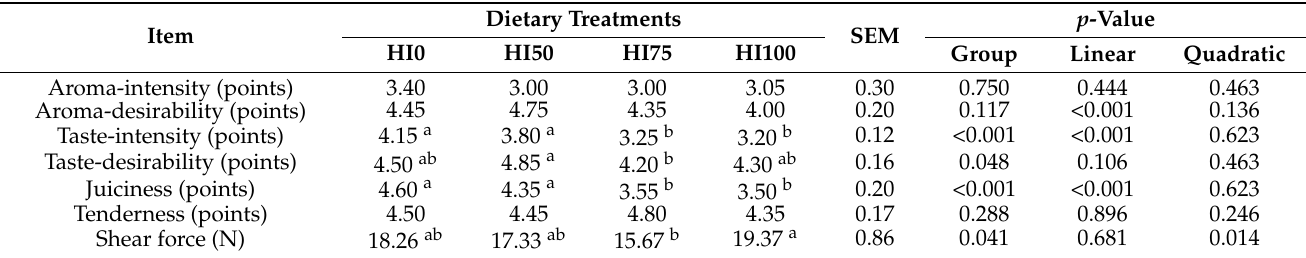
Table 7. Shear force values and the sensory properties of breast muscles in broiler chickens fed diets with different levels of full-fat Hermetia illucens (HI) larvae meal (arithmetic mean ± SEM).